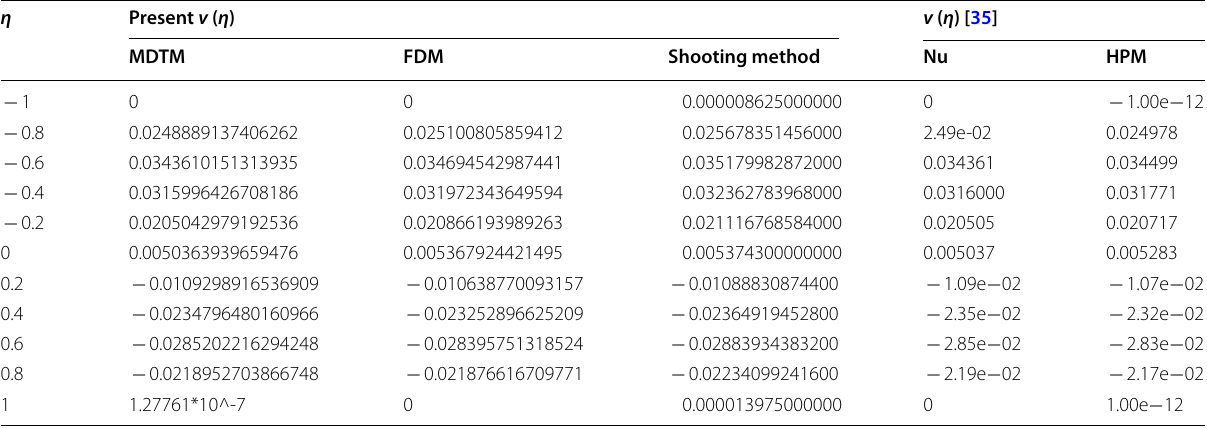
Table 4 Comparison solution by MDTM, FDM, and shooting method with Nu and HPM [35] for V ( η ) when ϕ Ha 0, 1 R 0, Ec 1, Pr 6.2, and α d = = = = =